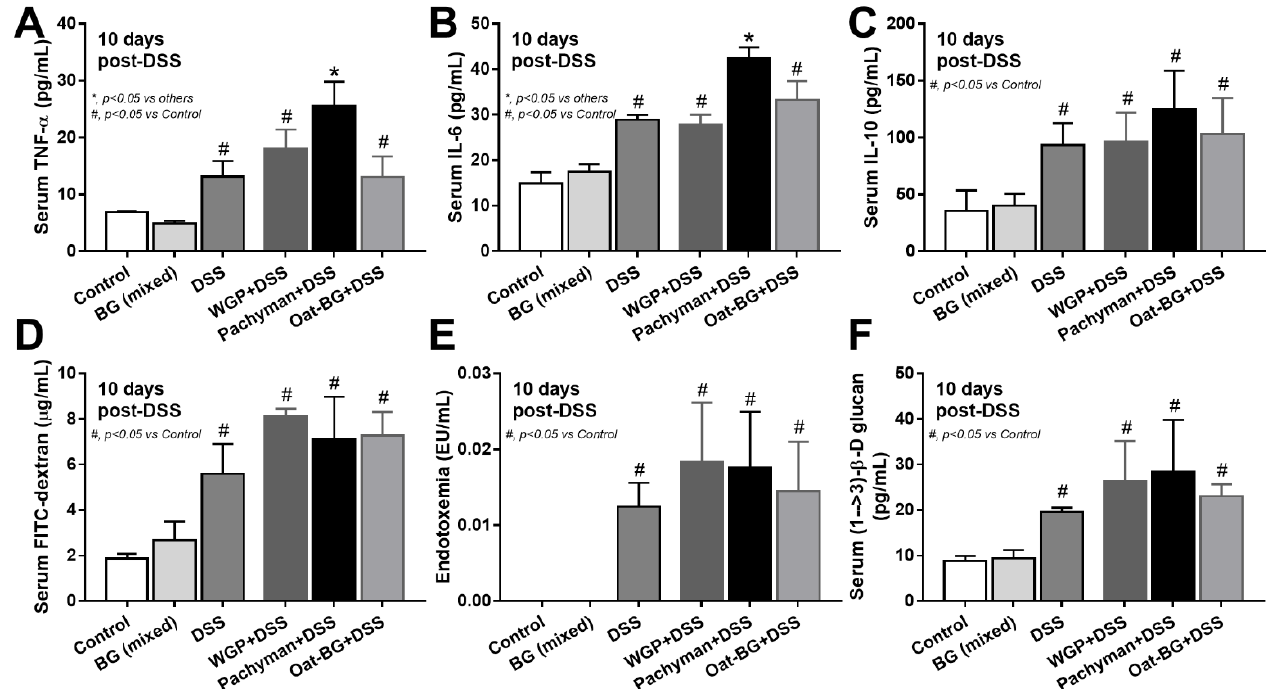
Figure 2. Characteristics of mice with drinking water (Control) with or without oral β -glucan gavage using whole-glucan particles (WGP), Pachyman, or Oat glucans (Oat-BG), which are combined into the BG (mixed) group, or dextran sulfate solution with or without several glucans, as indicated by serum cytokines (TNF- α , IL-6, and IL-10) ( A – C ); gut permeability (FITC-dextran assay) ( D ); endotoxemia ( E ); and serum (1 → 3)- β -D-glucan (BG) ( F ), which are shown ( n = 6–8/group). #, p < 0.05 vs. Control; *, p < 0.05 vs. other groups as determined by ANOVA with Tukey’s analysis. Data from oral glucan-administered mice using different types of glucans were combined as BG (mixed) due to the nonsignificant differences between groups.